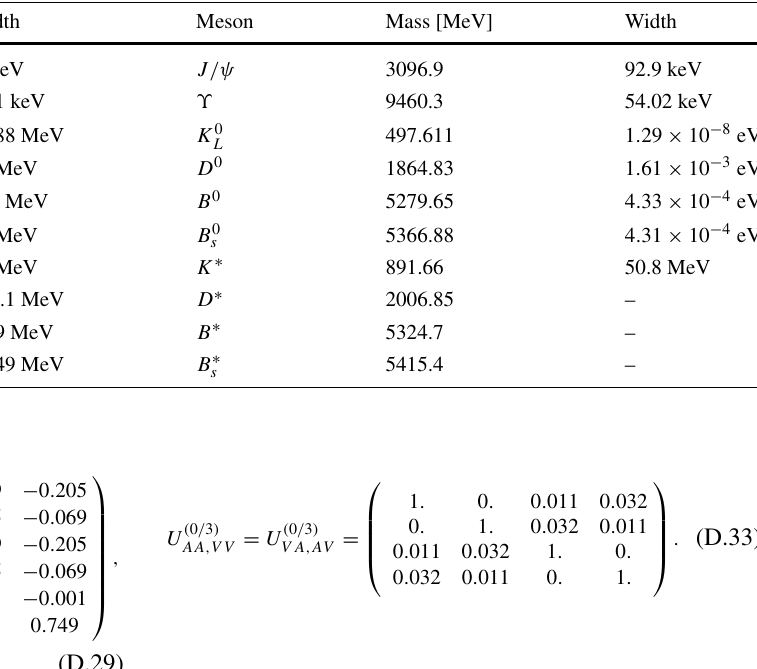
Table 9 Masses and widths of the mesons considered in this work, taken from Ref.